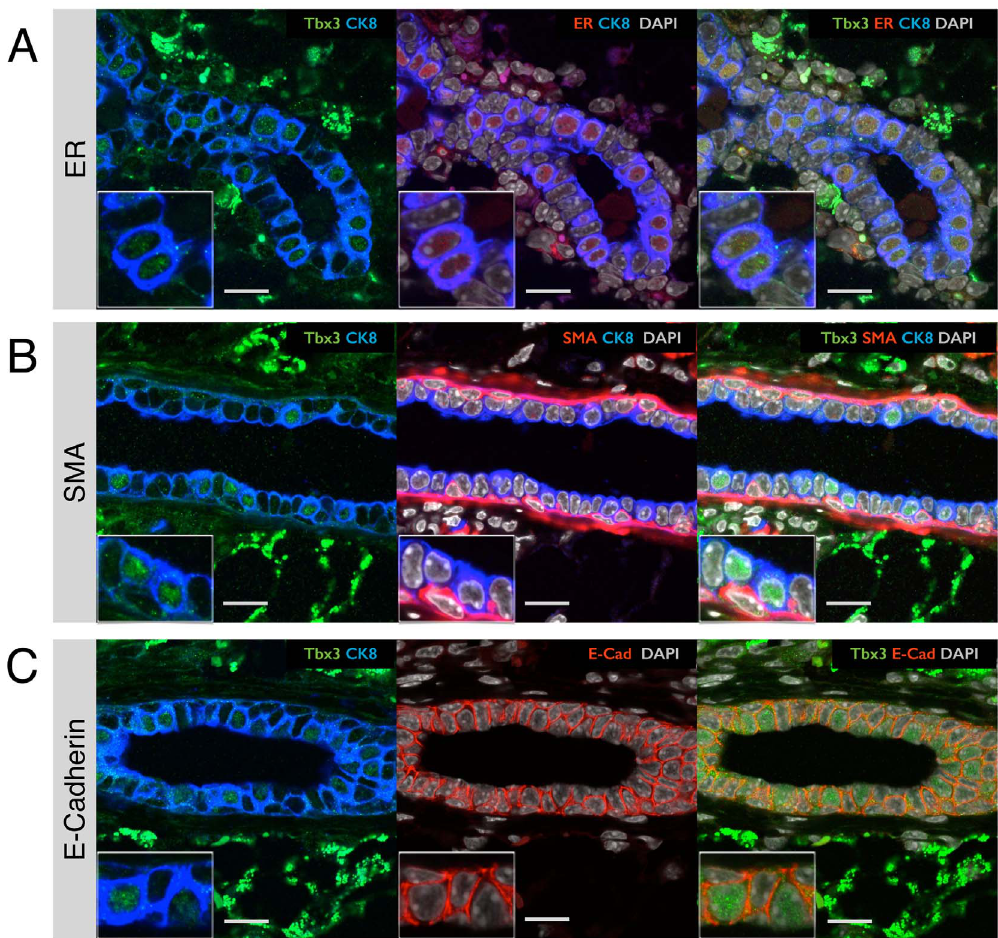
Figure 4. Tbx3 expression in epithelial cells in intact mammary glands. (A–C) Confocal immunofluorescence on paraffin sections of mammary glands from wildtype adult virgin mice. (A) Ductal structure probed with antibodies for Tbx3 (green), the estrogen receptor (ER, red) and the luminal cell marker cytokeratin-8 (CK8, blue). Nuclei are stained with DAPI (grey). (B) Duct probed for Tbx3 (green), the basal marker smooth muscle actin (SMA, red) and CK8 (blue). (C) Duct probed for Tbx3 (green), E-Cadherin (E-cad, red) and CK8 (blue). Images are representative of staining performed on paraffin sections of 3 independent animals. Scale bar is 20 m m or 10 m m for the inset.